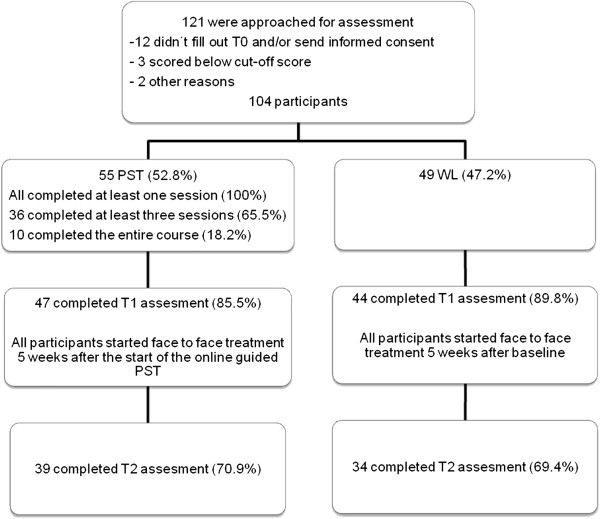
Participant flow.